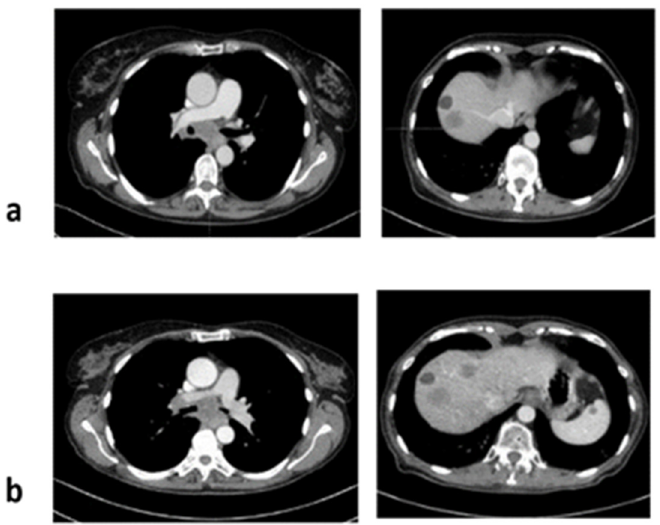
Figure 4. Computer tomography scans: ( a ) at baseline, and ( b ) at disease progression after four cycles of pembrolizumab.